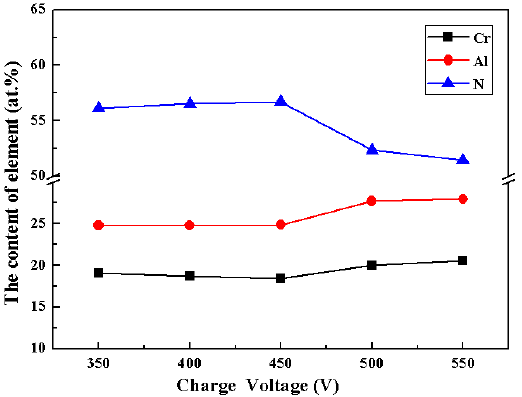
Figure 2. Chemical composition of AlCrN coatings as a function of charge voltage.